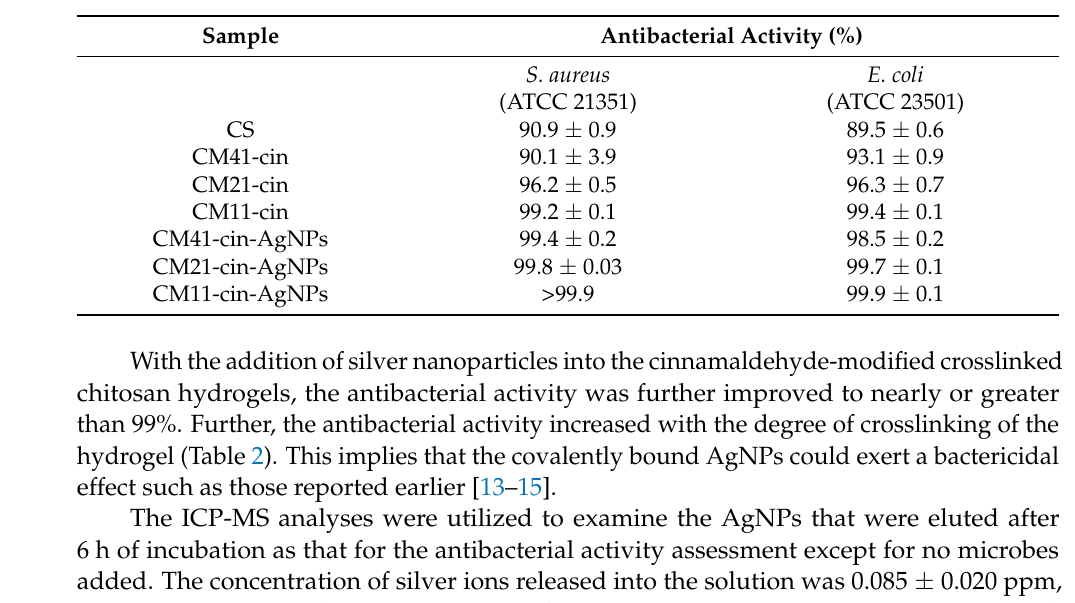
Figure 7. The representative agar plate image of viable E. coli counts after 6 h of contact with different hydrogels. Table 2. The antibacterial activity of various chitosan and crosslinked chitosan hydrogels ( n =